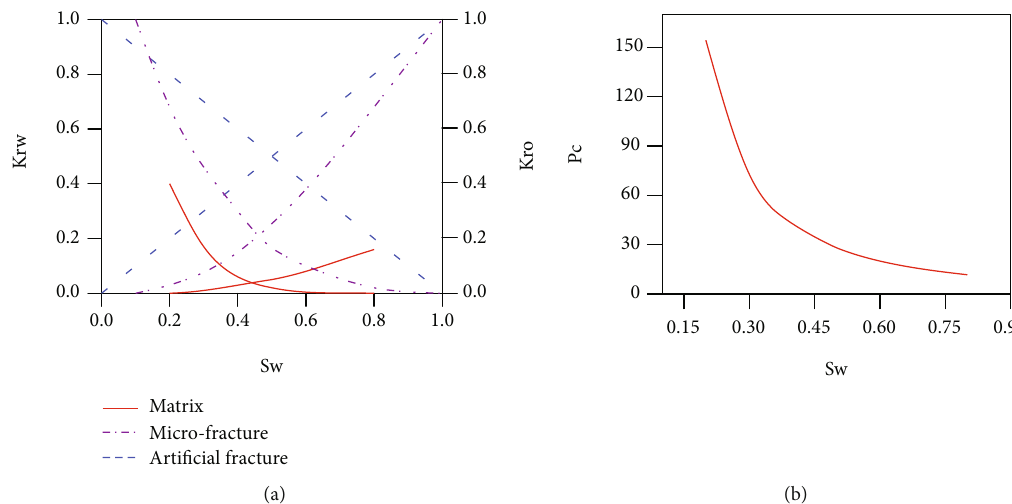
Figure 3: Relative permeability curve and matrix capillary force curve: (a) relative permeability curve and (b) matrix capillary force curve.